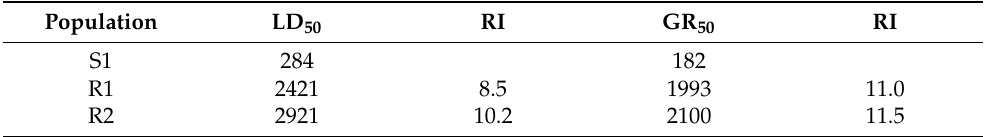
the susceptible control.